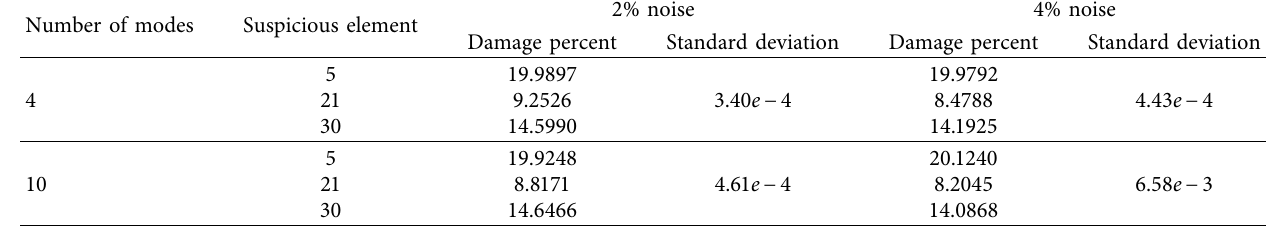
Figure 9: 15-element cantilever beam. Table 6: Damage detection results of step 2 for the frame.